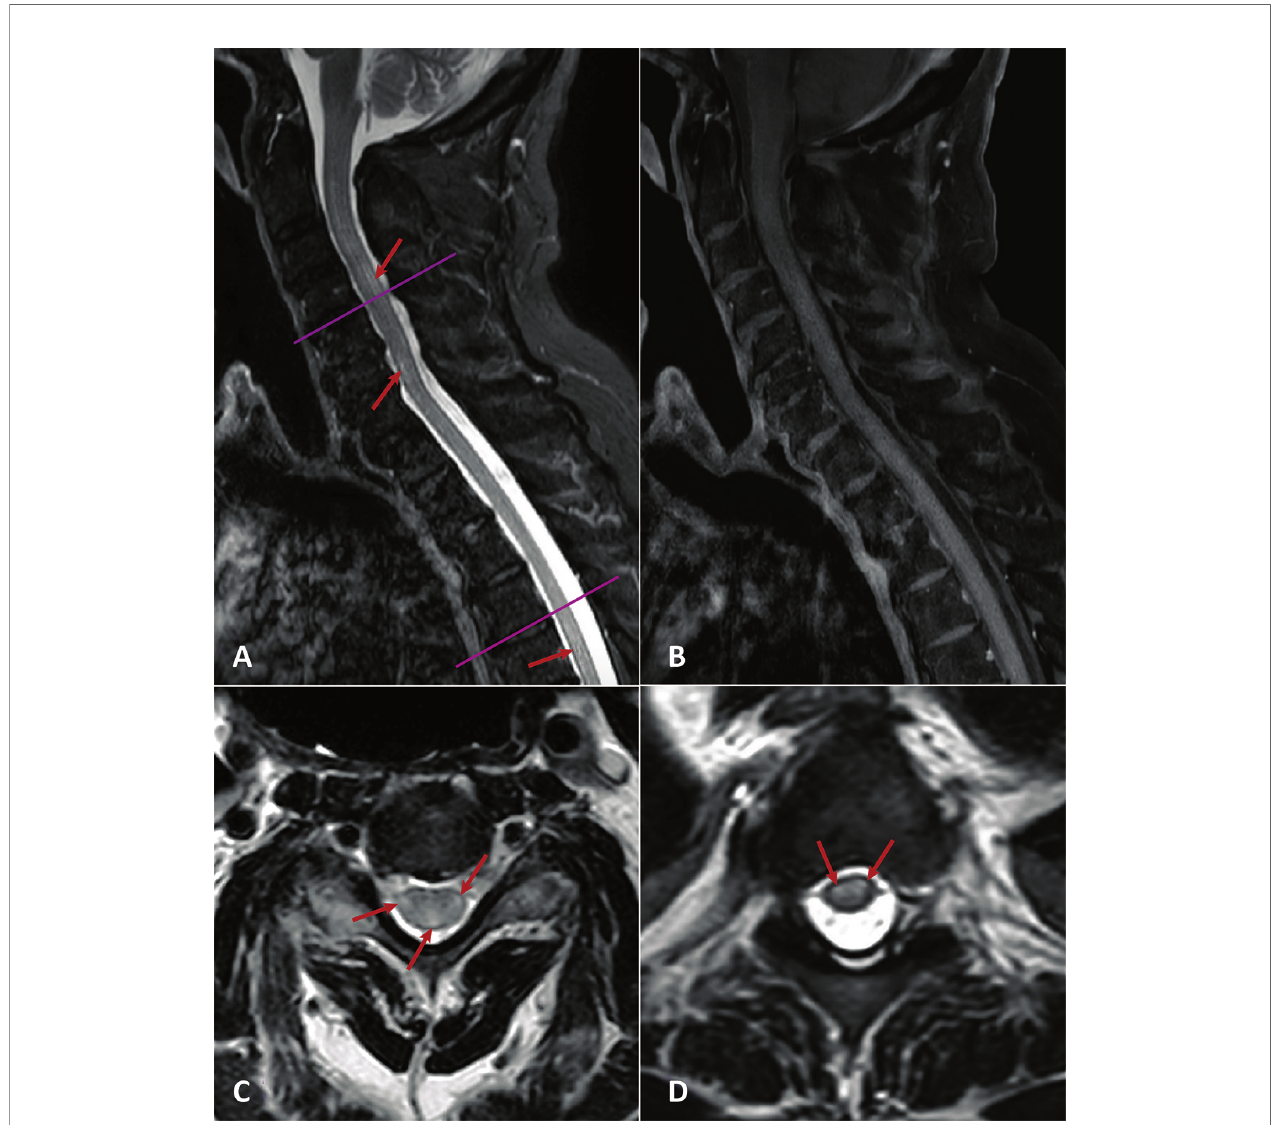
FIGURE 1 | Spinal cord MRI. (A) Sagittal Short-T1 Inversion Recovery: Mild cervical cord thickening and diffuse hyperintensities in cervical and dorsal cord (red arrows). (B) Sagittal T1 + gadolinium. No contrast enhancement. (C, D) Axial T2 (C4-5 and T3-4 levels) showing diffuse cord hyperintensities (red